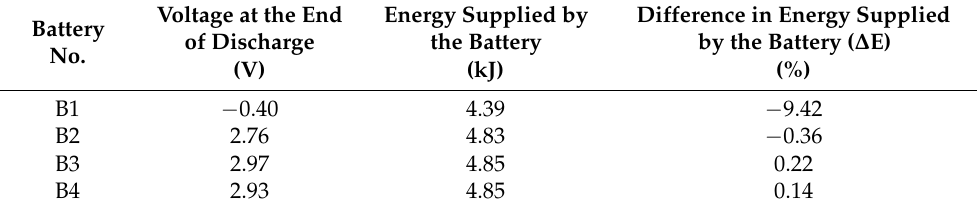
Table 1. Measurement results of the tested battery pack—first